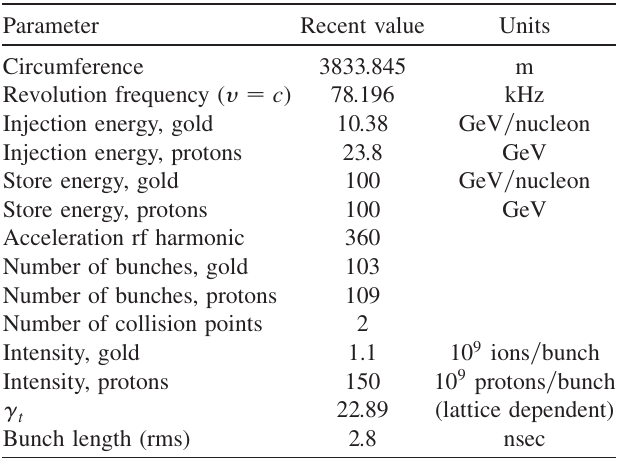
TABLE I. RHIC parameters from recent